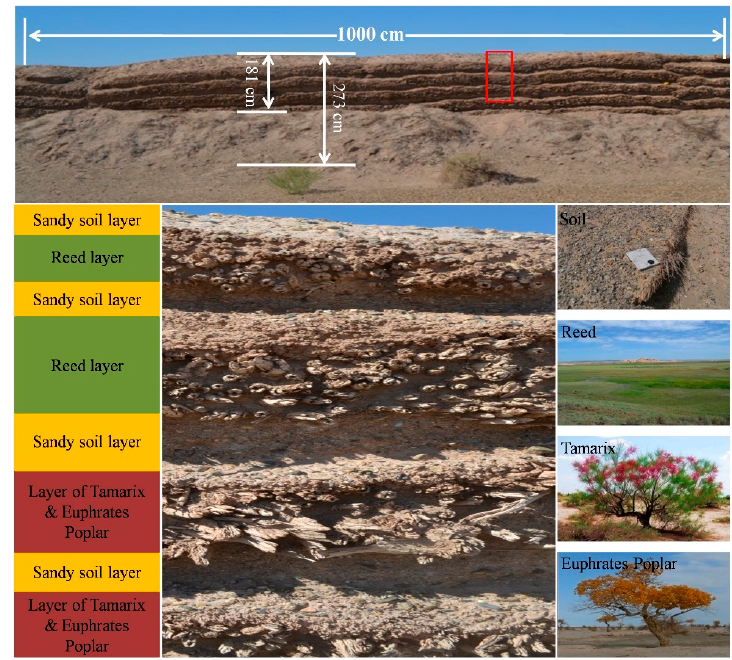
Figure 4. Field photograph showing the natural profile of a typical segment of the GH with remained walls on the ground in Dunhuang.